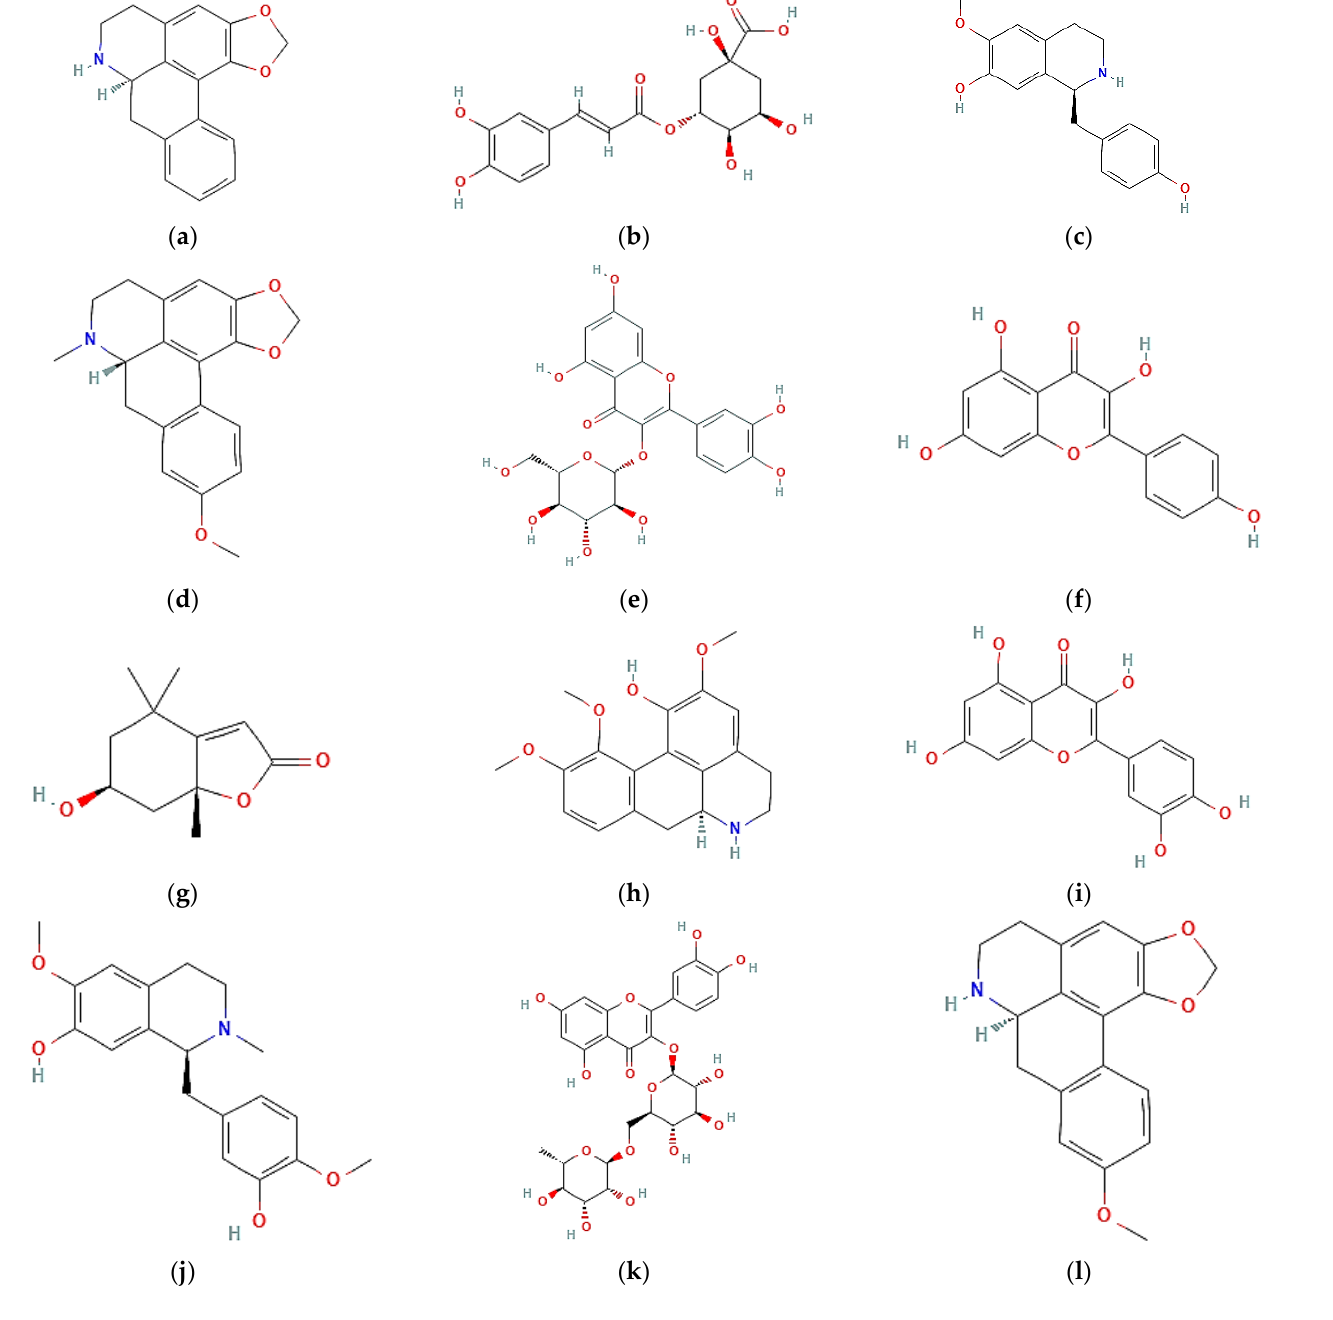
Figure 3. Bioactive compound structures found in A. muricata leaf ethanol extract: ( a ) anonaine; ( b ) chlorogenic acid; ( c ) coclaurine; ( d ) isolaureline; ( e ) isoquercetin; ( f ) kaempferol, ( g ) loliolide; ( h ) norcorydine; ( i ) quercetin; ( j ) reticuline; ( k ) rutin; ( l ) xylopine. The diameter of renal glomeruli was significantly higher in the positive controls when compared to negative controls ( p > 0.05, indicated normal data distribution). However, treatment with SLEE significantly reduced the glomerular diameter to the normal distribution values (Table 3).